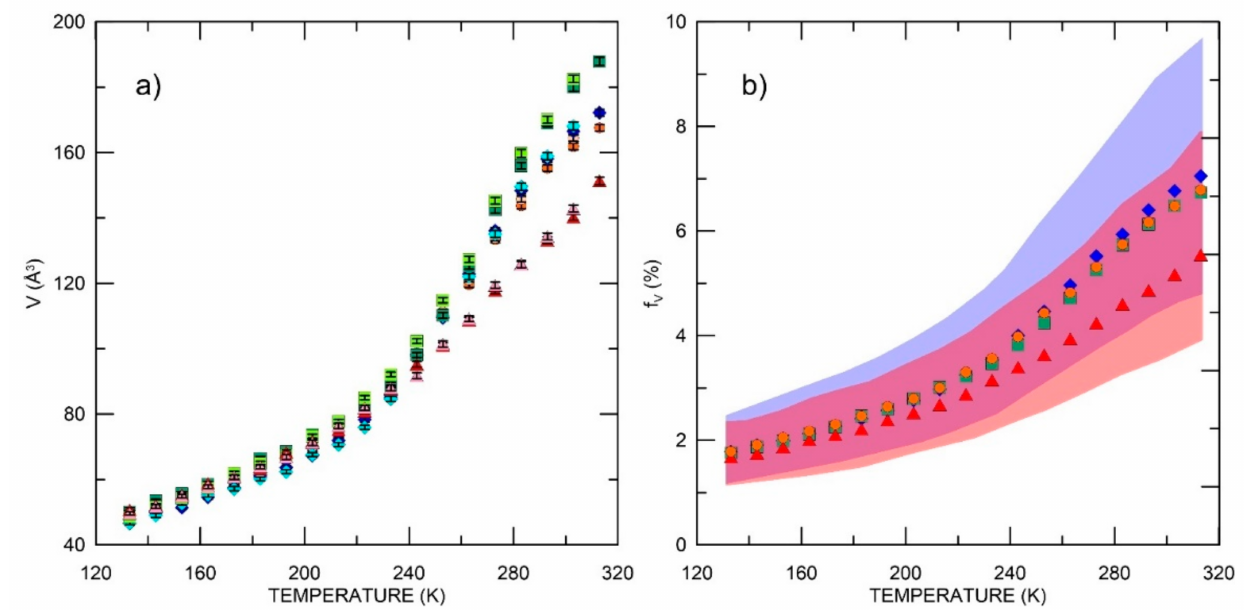
Figure 6. Free volume ( a ) and relative free volume fraction ( b ) as a function of tempera- ture in increasing temperature: ELO/PI—orange dots, ELO/10RD1/PI—dark blue, diamonds, AESO/VDM—dark green squares, AESO/VDM/DMPA—red triangles; and decreasing of temper- ature: ELO/PI—creamy dots, ELO/10RD1/PI—light blue diamonds, AESO/VDM—light green squares, AESO/VDM/DMPA—pink triangles. In the figure to the right, the points correspond to C = 0.0014. For C in the range 0.001 to 0.002, the blue and red areas marked results for ELO/PI and AESO/VDM/DMPA,